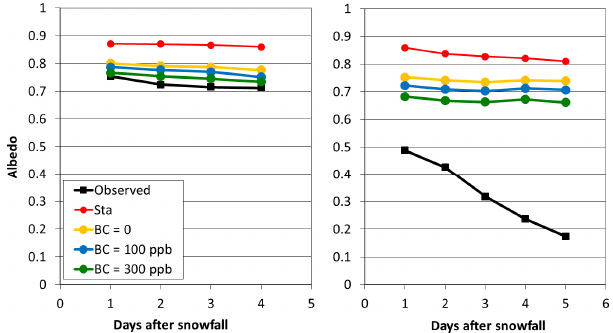
Figure 4. Comparison of observed (black) and simulated daily aver- ages of the snow albedo at NCO-P for the period after 16 February 2007 (left) and 26 April 2006 (right). Simulations were performed with the standard Crocus model (red) and with the upgraded model including radiative transfer with constant BC concentrations of 0 (yellow), 100 (blue), and 300ppb